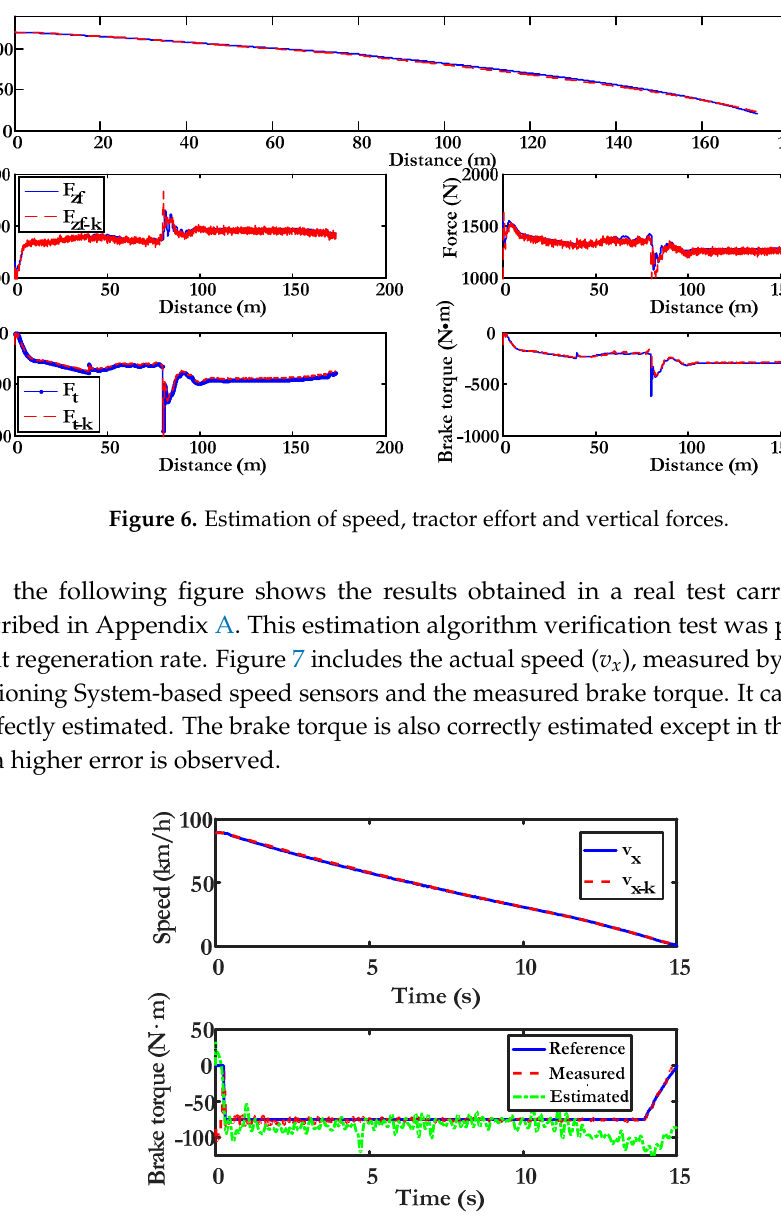
Figure 7. Estimation of speed and brake torque.